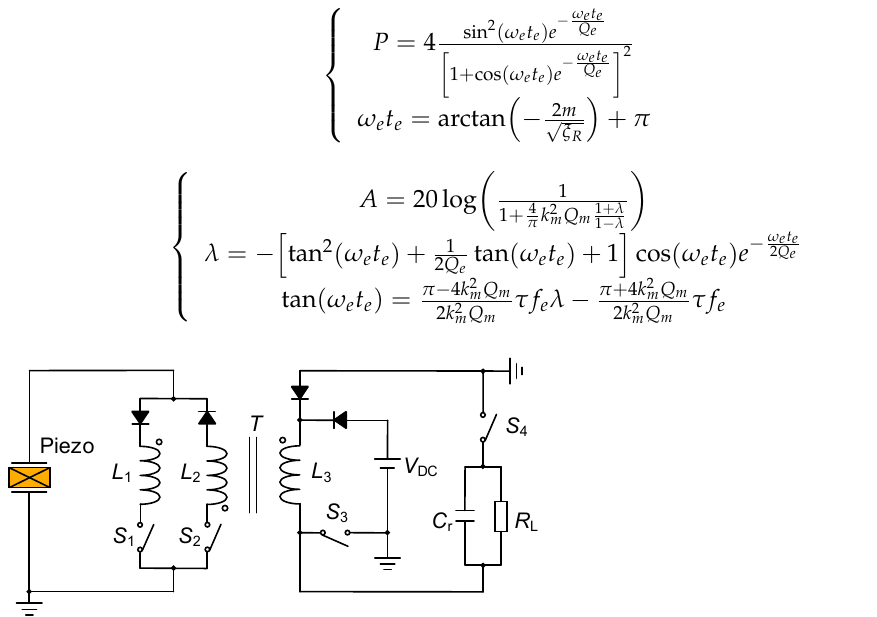
Figure 8. Piezoelectric interface circuit based on flyback transformer.